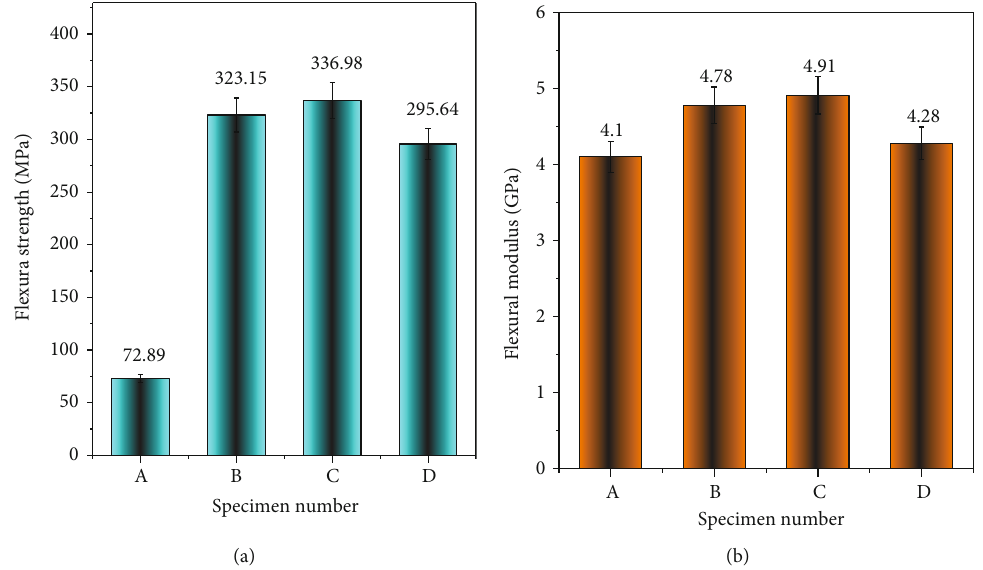
Figure 6: Kevlar and hemp-based hybrid composites: (a) fl exural strength and (b) fl exural